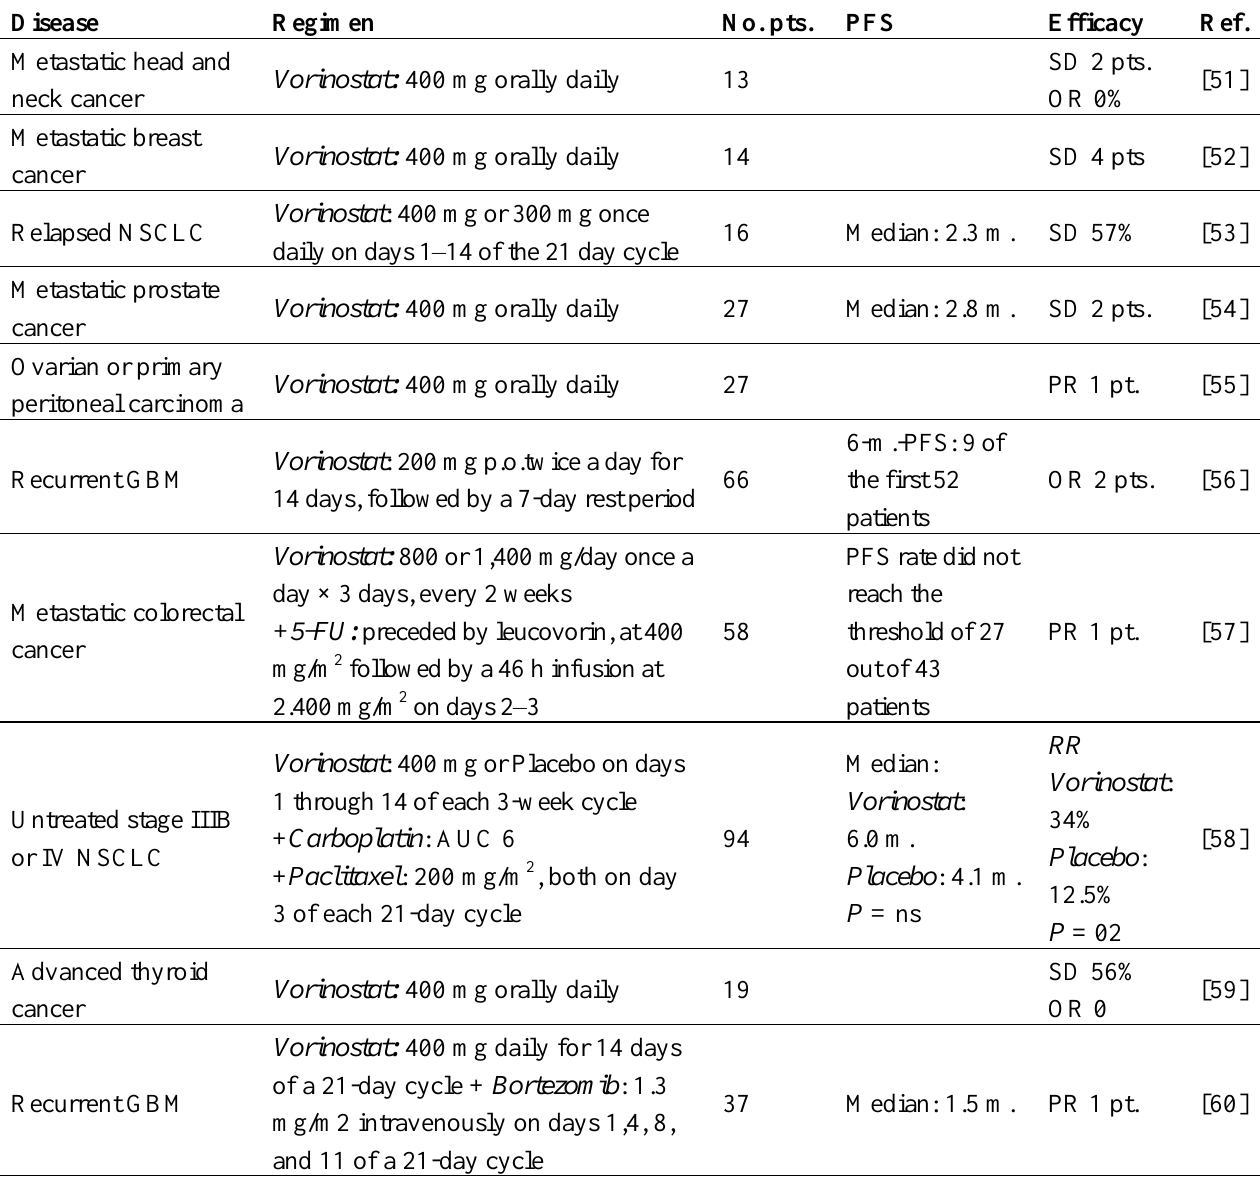
Table 3. Vorinostat in published phase II clinical trials in solid tumors. Disease Regimen No. pts. PFS